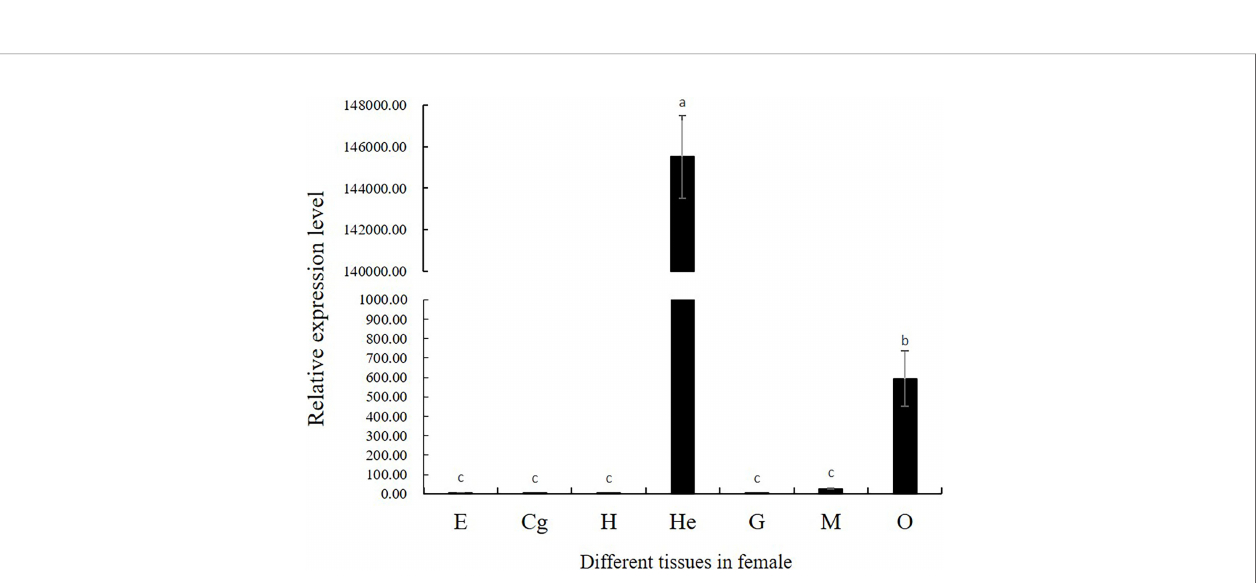
FIGURE 4 | Tissue distribution of Mn-CL2 . E, eyestalk; Cg, cerebral ganglion; H, heart; He, hepatopancreas; G, gill; M, muscle; O, ovary. Bars with different small letters indicated signi fi cant differences (P <